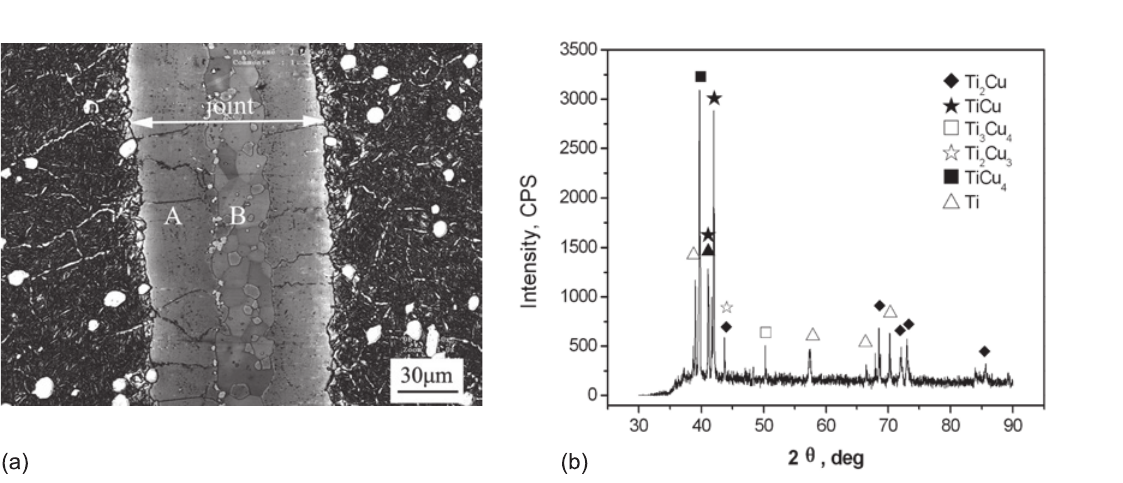
Fig. 4: Joint produced at 950 °C × 30 min. a: joint microstructure, b: XRD pattern taken from the fracture surface of the